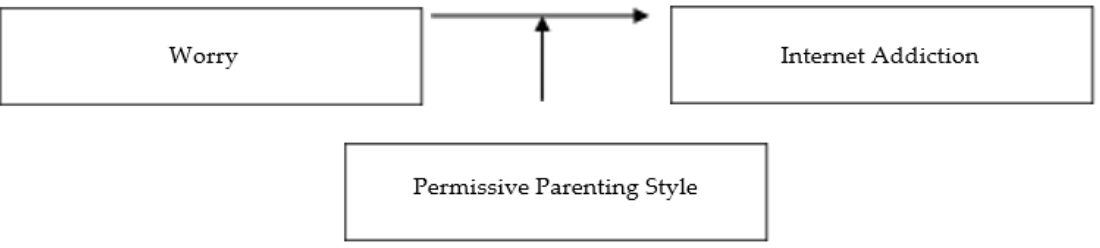
Figure 1. Hypothesized moderating effect of the permissive parenting style on the relationships between worry and Internet addiction.